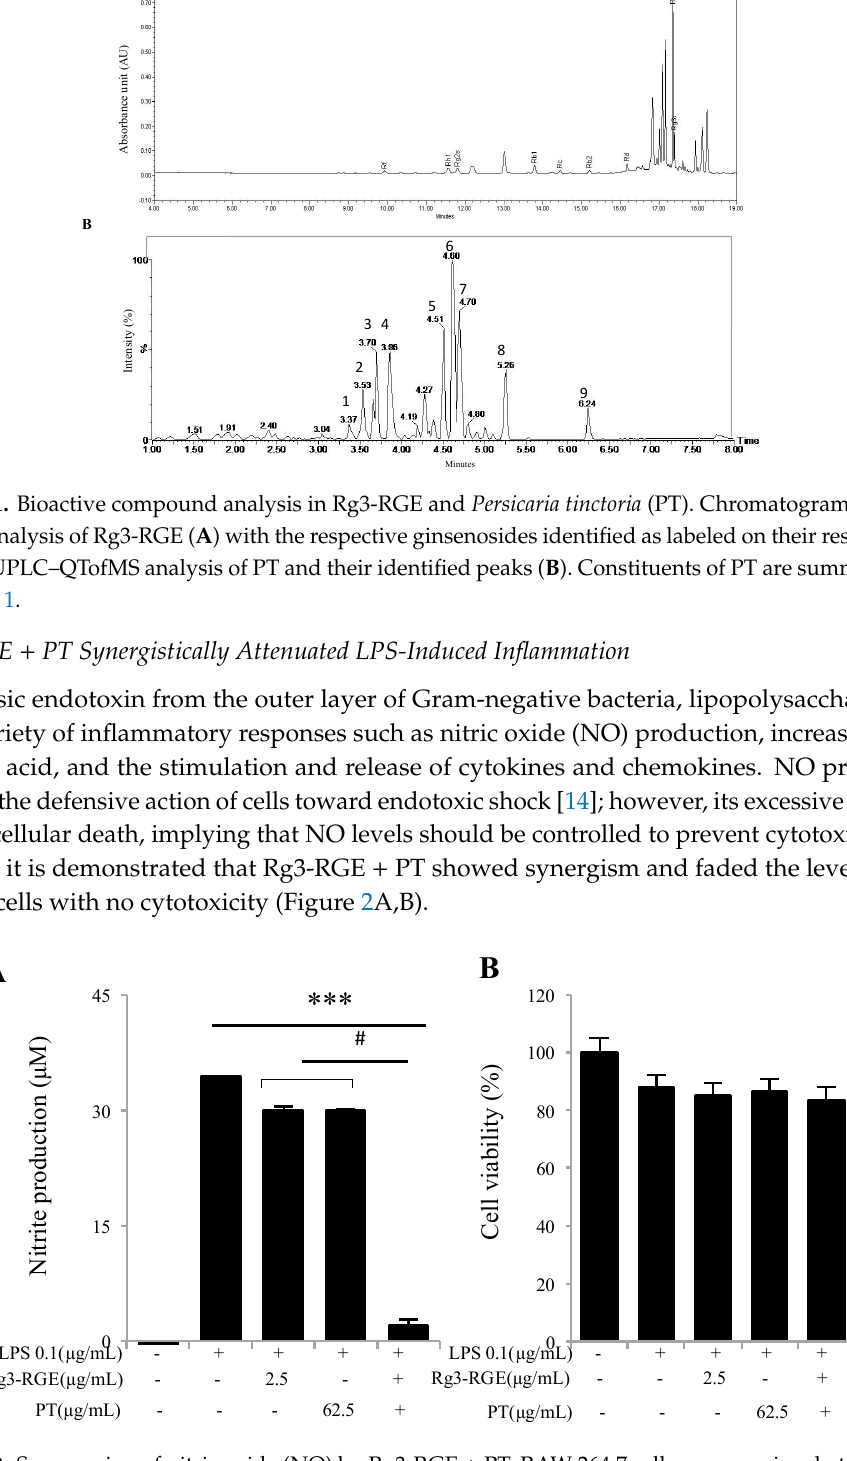
Figure 2. Suppression of nitric oxide (NO) by Rg3-RGE + PT. RAW 264.7 cells were pre-incubated with Rg3-RGE + PT for 30 min and then stimulated with LPS for 18 h. Cell supernatant was then mixed with equal amounts of Griess reagent and the NO production measured ( A ). E ff ects of Rg3-RGE + PT on cell viability were measured by MTT (3-(4,5-dimethylthiazol-2-yl)-2,5-diphenyltetrazolium bromide) assay ( B ). *** p < 0.001 is considered significant compared to LPS and # p < 0.01 compared to inhibition by only Rg3-RGE or PT. Values in bar graphs represent mean ± SD of three independent experiments. Triplicates were completed within 10 days.